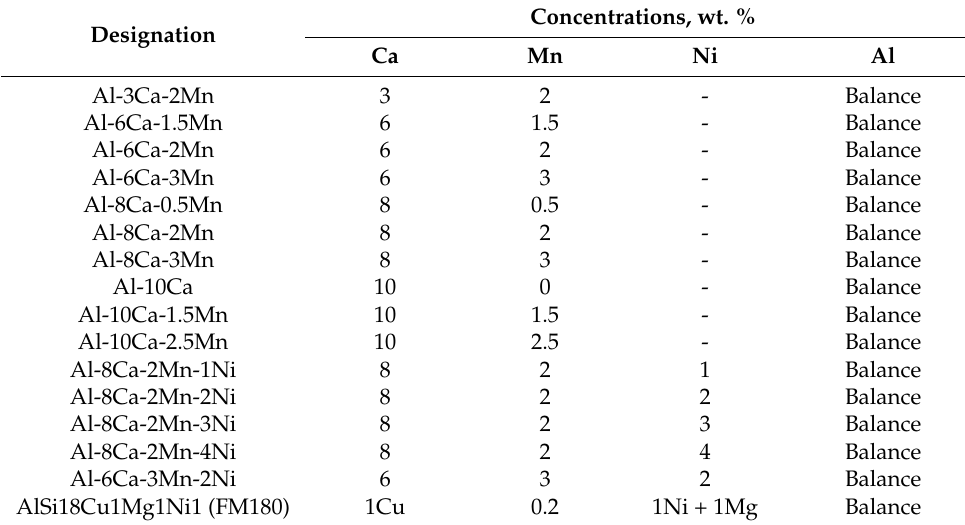
Table 1. Chemical composition of the experimental